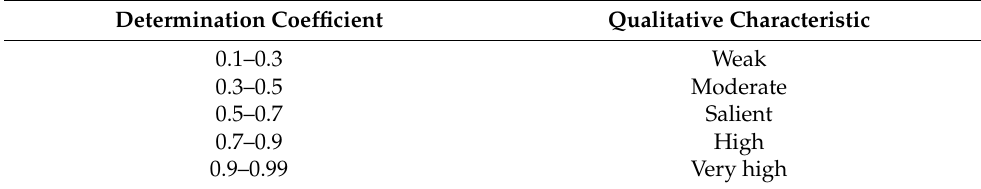
Table 10. Chaddock scale.